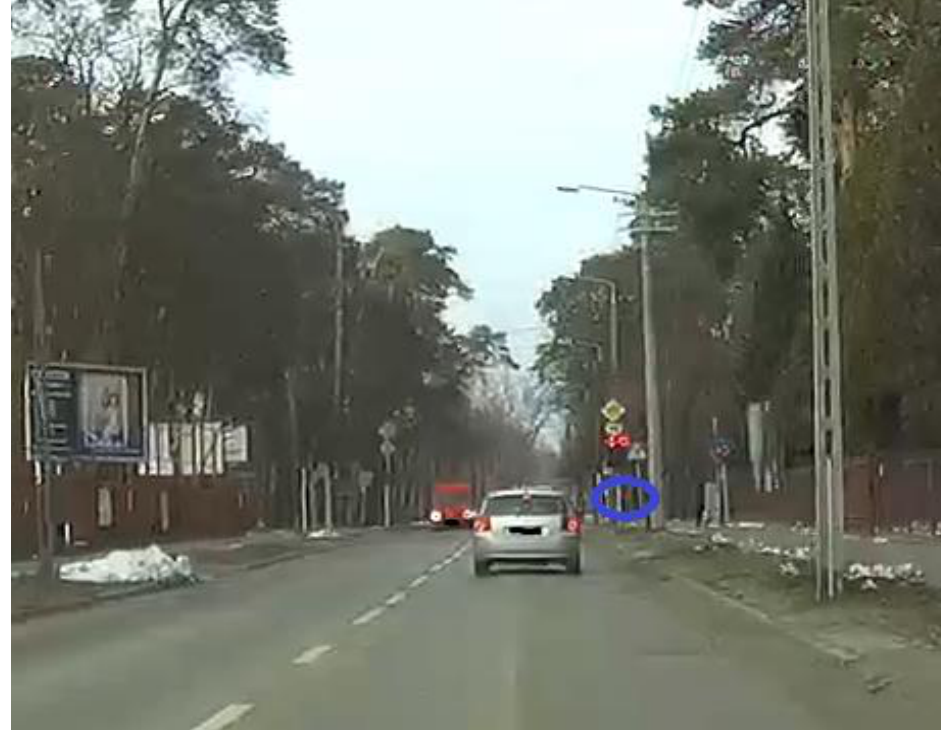
Figure 6. A photo of a double traffic light system. The blue oval indicates the red roadside advertisement (the authors’ own study).